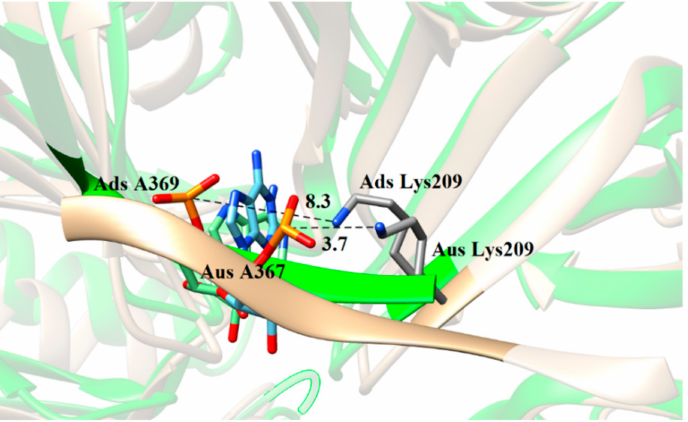
Figure 5. The superposition of Ads and Aus structure in the lowest-energy structures of MD trajectory (Aus in gold, Ads in green). The distance (Å) between the charged group of Lys209 and the phosphate group of adenine nucleotide A367 in Aus system and A369 in Ads system was